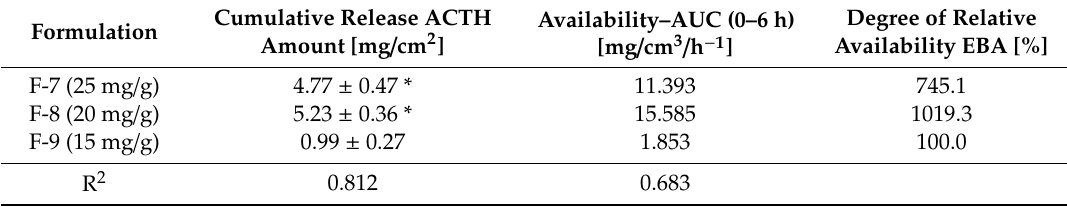
Table 3. Parameters of ACTH availability from hydrogel